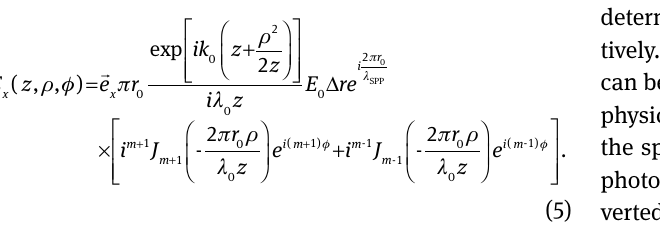
the same angular width and polarization. Circular polari- placements of 200 nm and 500 nm. Through